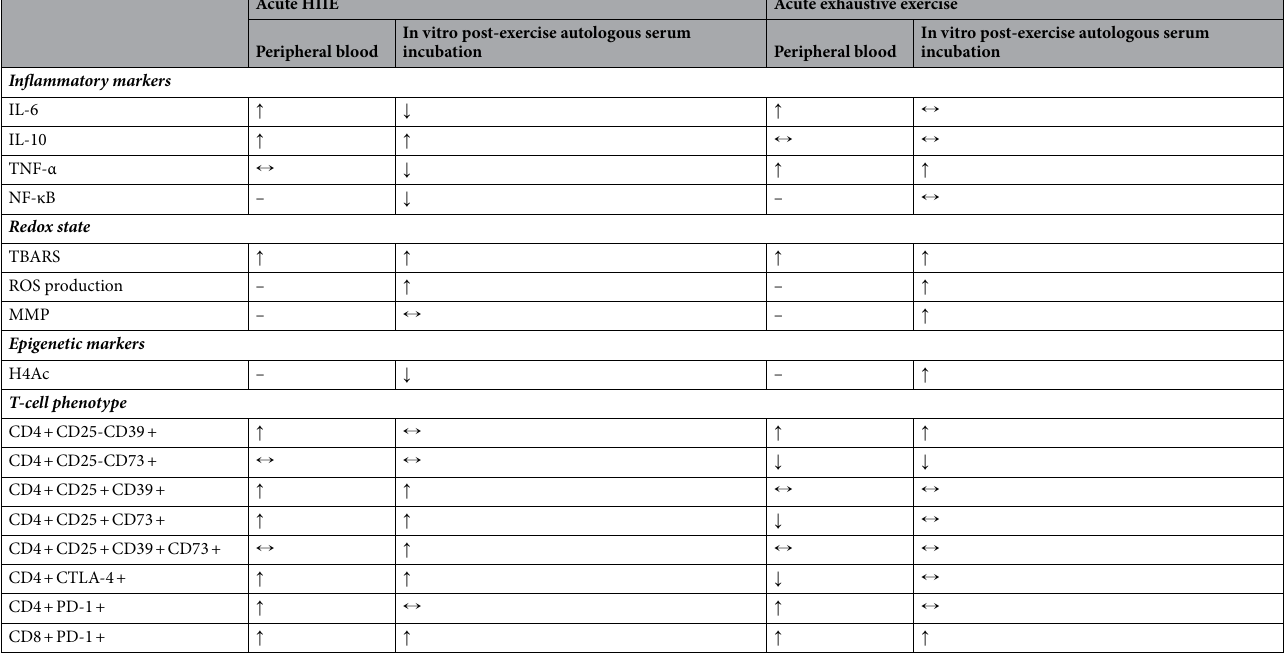
Table 3. Summary of the differences between peripheral blood immune response and in vitro experiments with the autologous serum of obese men acquired after two exercise sessions. ↔ , unchanged; ↑ , increased; ↓ , decreased; IL, interleukin; NF-κB, Nuclear Factor-kappaB; TNF-α, Tumor necrosis factor-alpha; TBARS, Thiobarbituric acid reactive substances; MMP, mitochondrial membrane potential; H4Ac, Histone H4